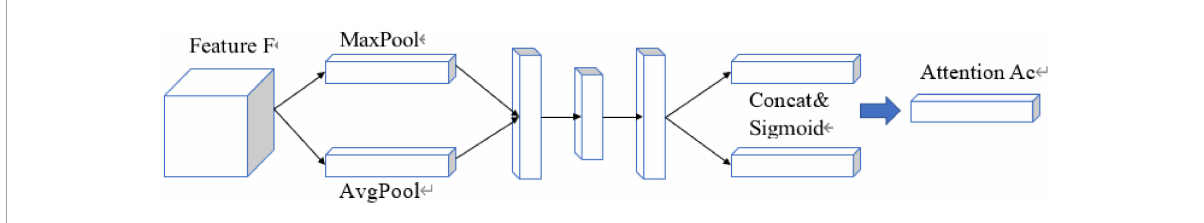
FIGURE5 Structure of 3D attention mechanism gate